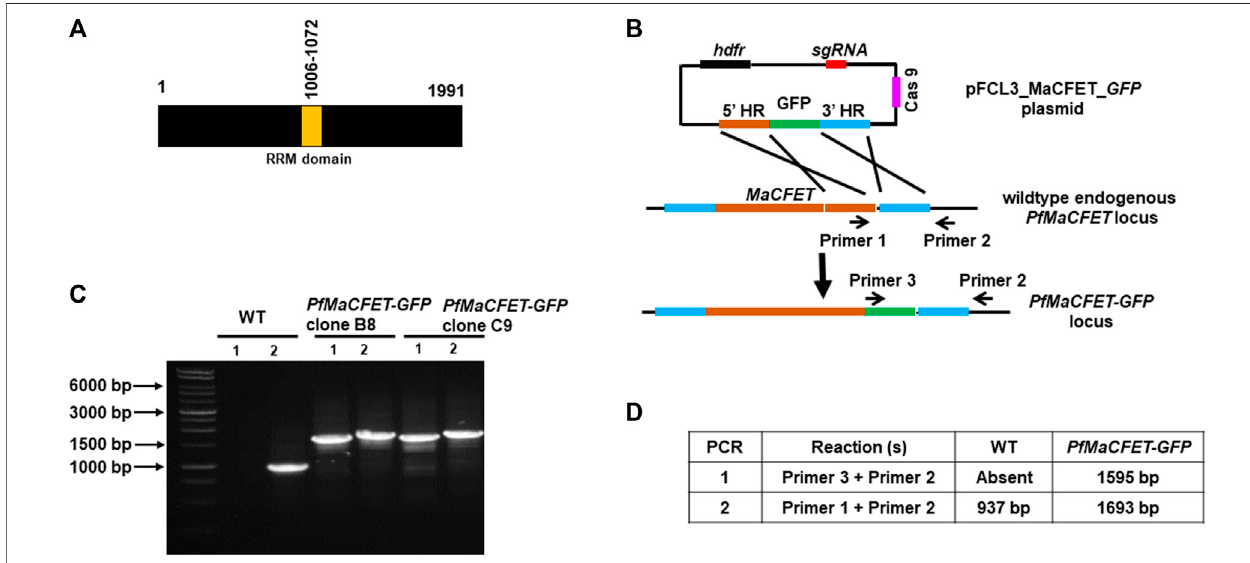
FIGURE 1 | Generation of PfMaCFET-GFP parasites. (A) Schematic for Pf MaCFET domains showing an RNA recognition motif (RRM) domain. (B) Schematic for endogenous tagging of the PfMaCFET locus with GFP. The pFCL3_MaCFET_GFP plasmid contains homology arms from the 5 ′ (5 ′ HR) and 3 ′ (3 ′ HR) regions of the PfMaCFET locus, a single guide RNA seq (sgRNA), Cas9 and human dihydrofolate reductase (hDHFR). (C) Con fi rmation of PfMaCFET-GFP parasite generation by genotyping PCR. The oligonucleotides were designed and positions are indicated by arrows in (B) to con fi rm the introduction of the GFP tag. (D) The expected amplicon sizes for different sets of PCR primer combinations are indicated.